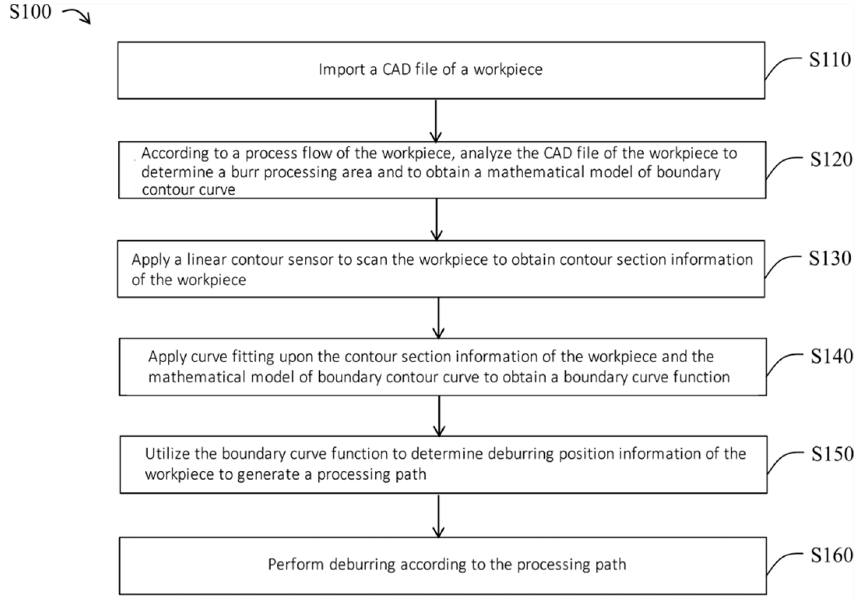
Figure 1. 3D online deburring trajectory generation